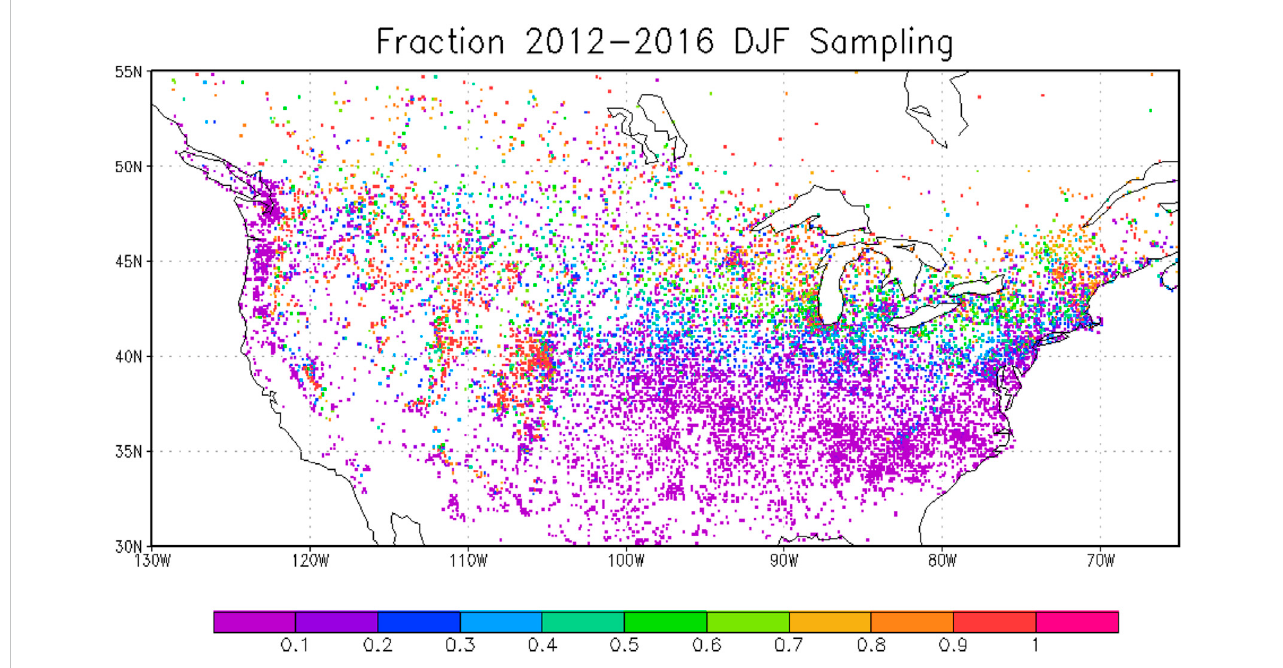
FIGURE 1 The study region (30 ° N-55 ° N). Depicted is the fraction of days in DJF months for the GHCN stations over 2012 – 2016 with snow-depth sampling. Sampling = 1 if all days are